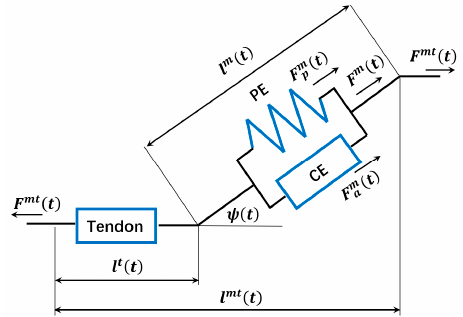
Figure 1. Representation of the muscle–tendon unit based on Hill’s muscle model. The muscle–tendon unit is modeled as a muscle fiber in series with a tendon. Structures putatively responsible for the muscle force are called the passive element (PE) and the contractile element